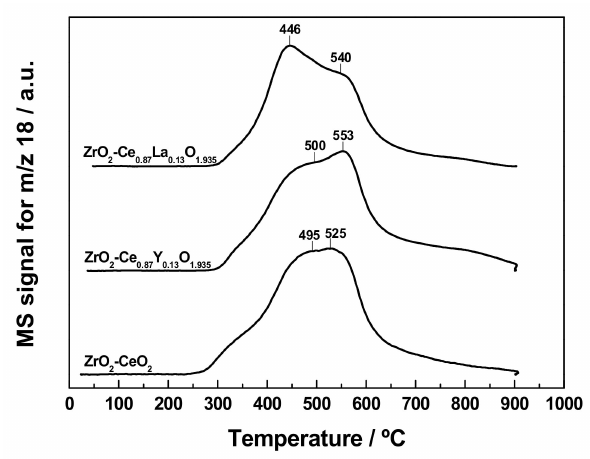
Figure 6. Temperature-programmed reduction mass spectrometry (TPR-MS) profiles registered for the undoped and Ln-doped ZrO 2 -CeO 2 samples previously subjected to a reduction treatment in H 2 (5%) / Ar, at 900 ◦ C for 1 h.